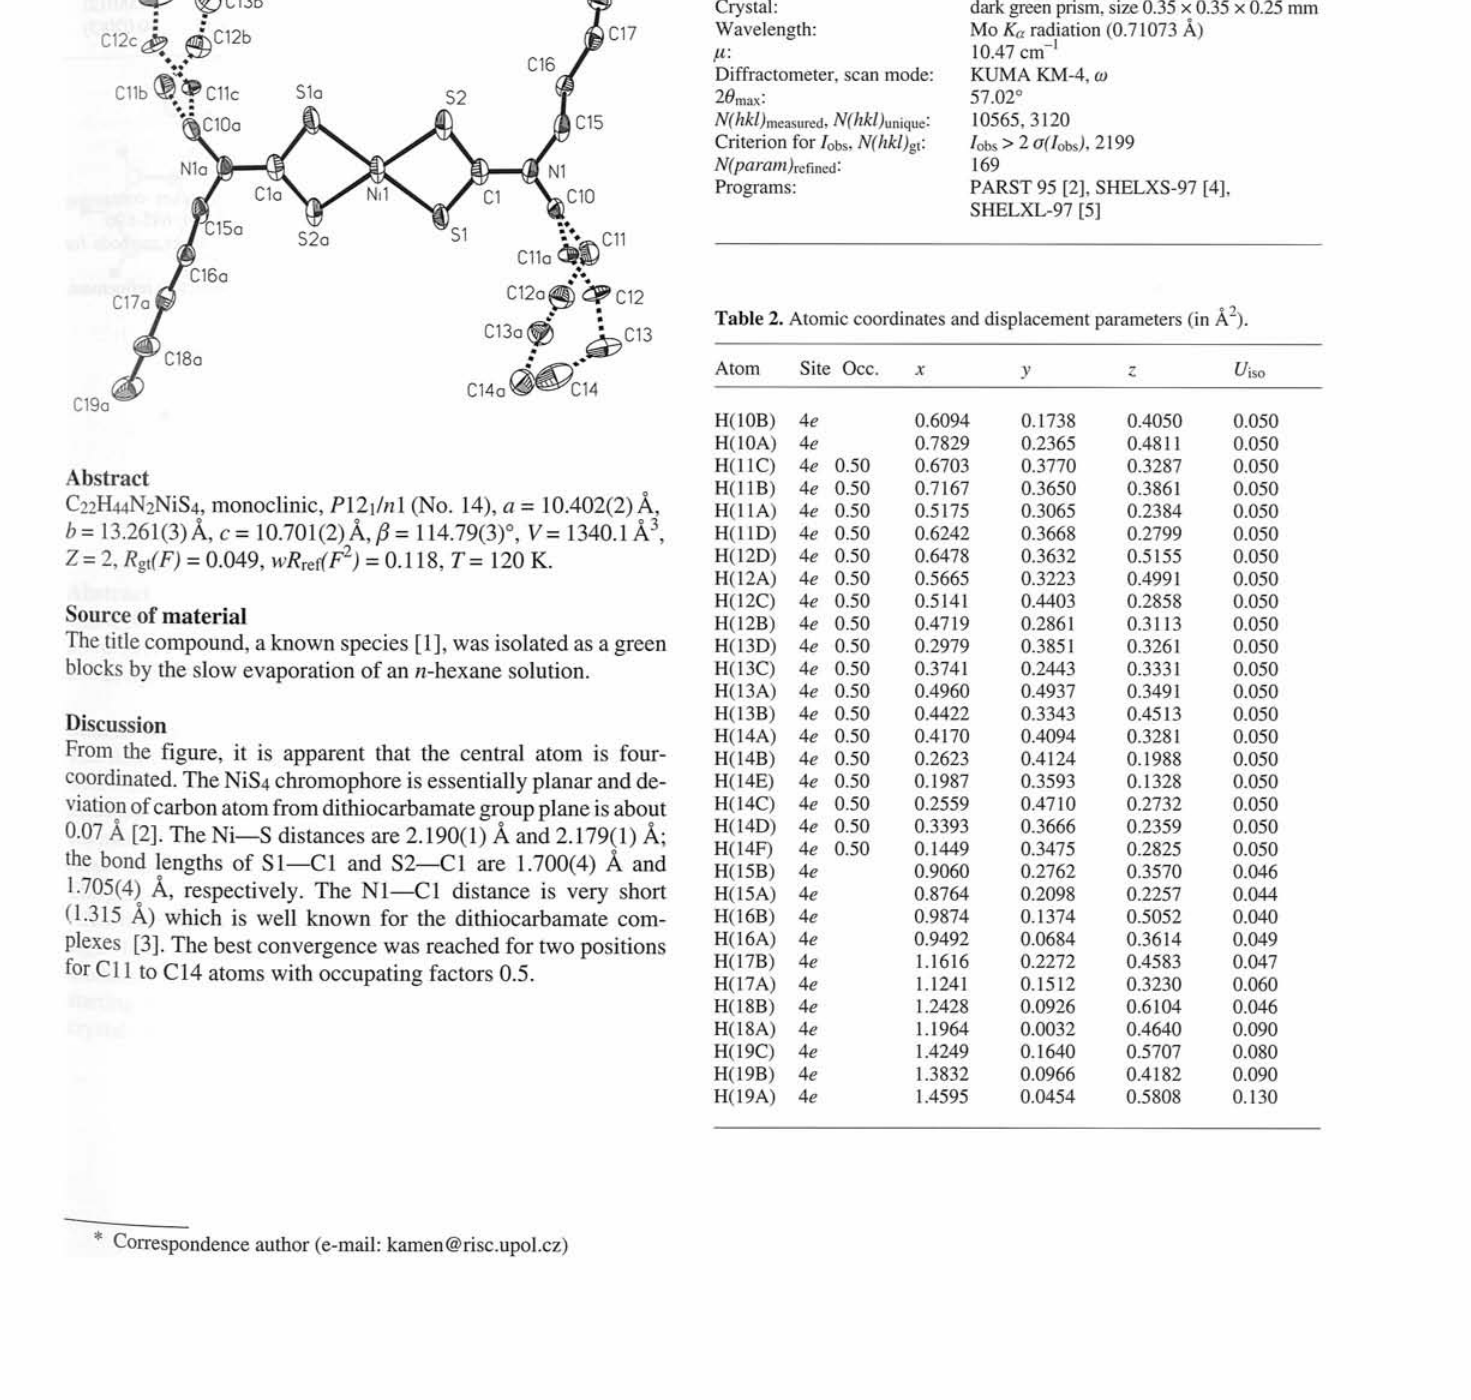
Table I. Data collection and handling.